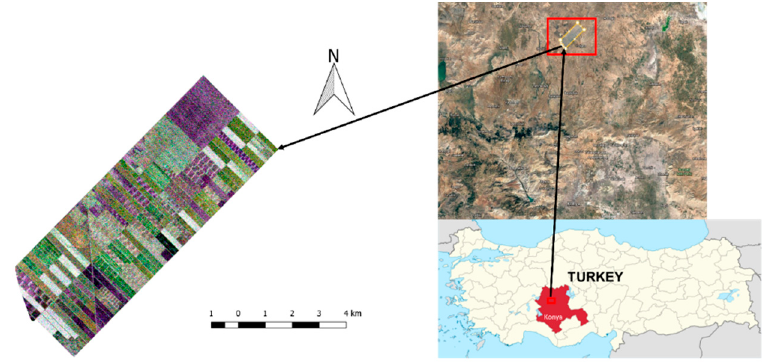
Figure 1. Test site (R/G/B: HH/VH/VV).